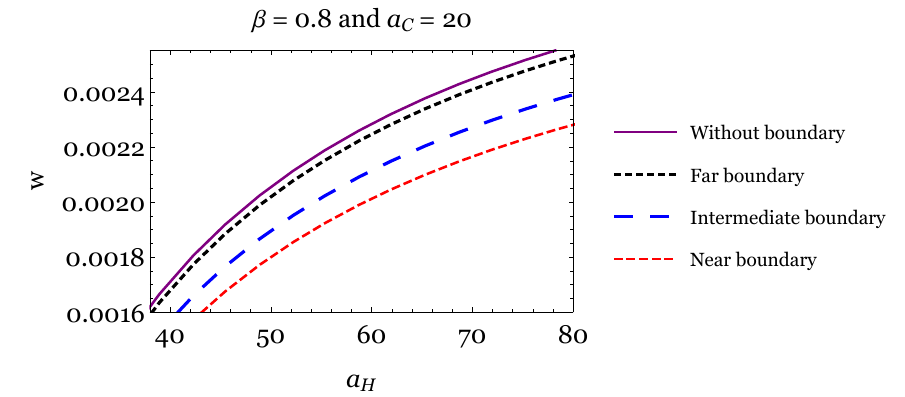
Figure 9. Behaviour of the work output with respect to a H for fixed values of β and a C